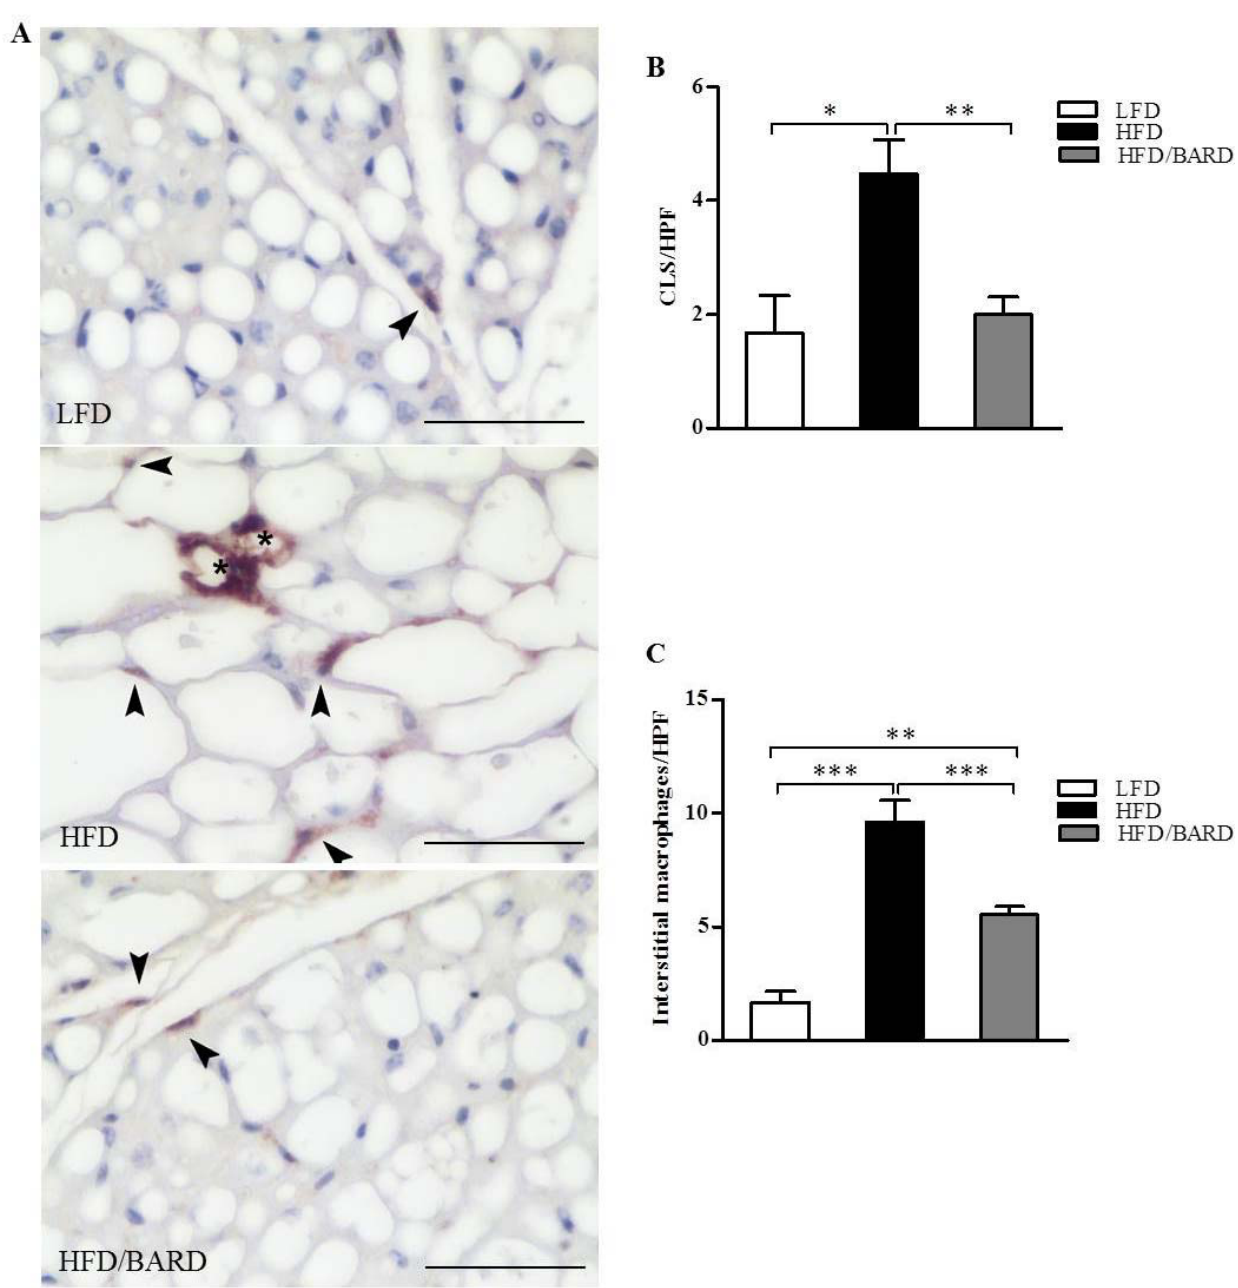
Figure 2. Effect of bardoxolone methyl (BARD) on the expression of F4/80 macrophages in brown adipose tissue of mice fed: low-fat diet (LFD), high-fat diet (HFD), and high-fat diet supplemented with BARD (HFD/BARD). ( A ) F4/80 stained sections (×40). Bar = 50 µm; ( B ) Number of crown-like structures (CLS) per high-power field (HPF); ( C ) Number of interstitial macrophages per HPF. The asterisks illustrate CLS while the arrowheads demonstrate single interstitial macrophages. All data are presented as mean ± SEM. * p < 0.05, ** p < 0.01, *** p <